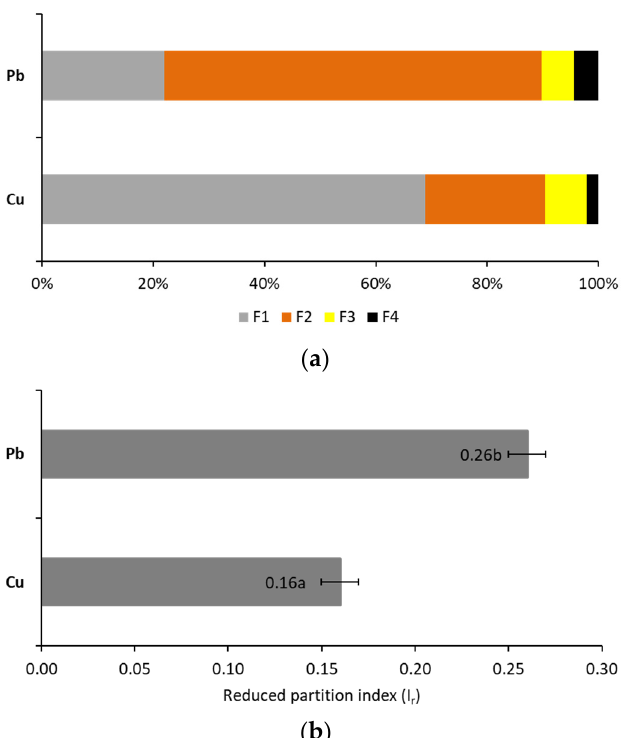
Figure 2. Metal distribution ( a ) and stability (as I r ) ( b ) in smelter contaminated soil. For I r , different letters indicate significant differences in metal stability in soil ( p < 0.05).